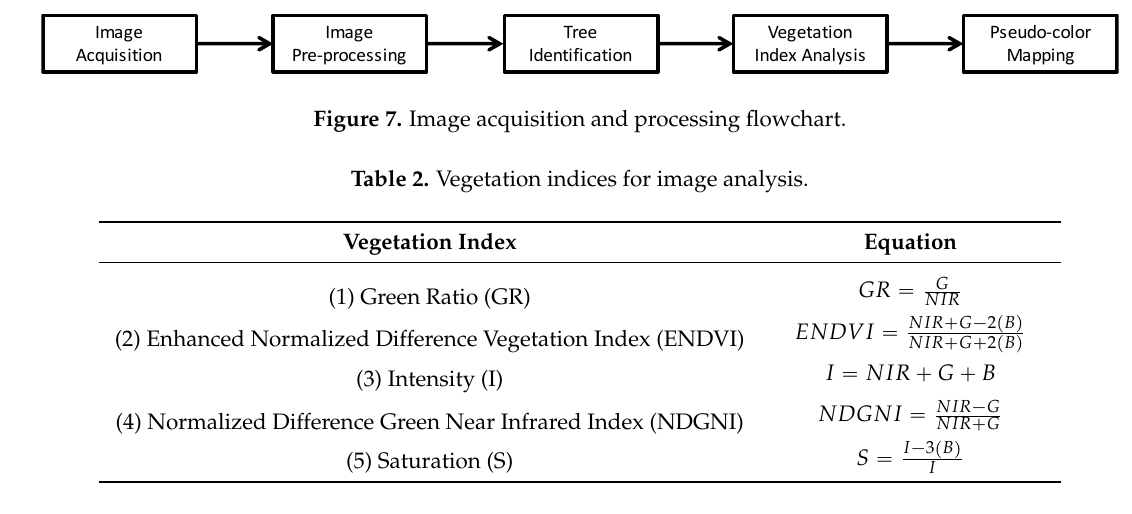
Figure 6. Sample multispectral image of the target orchard.